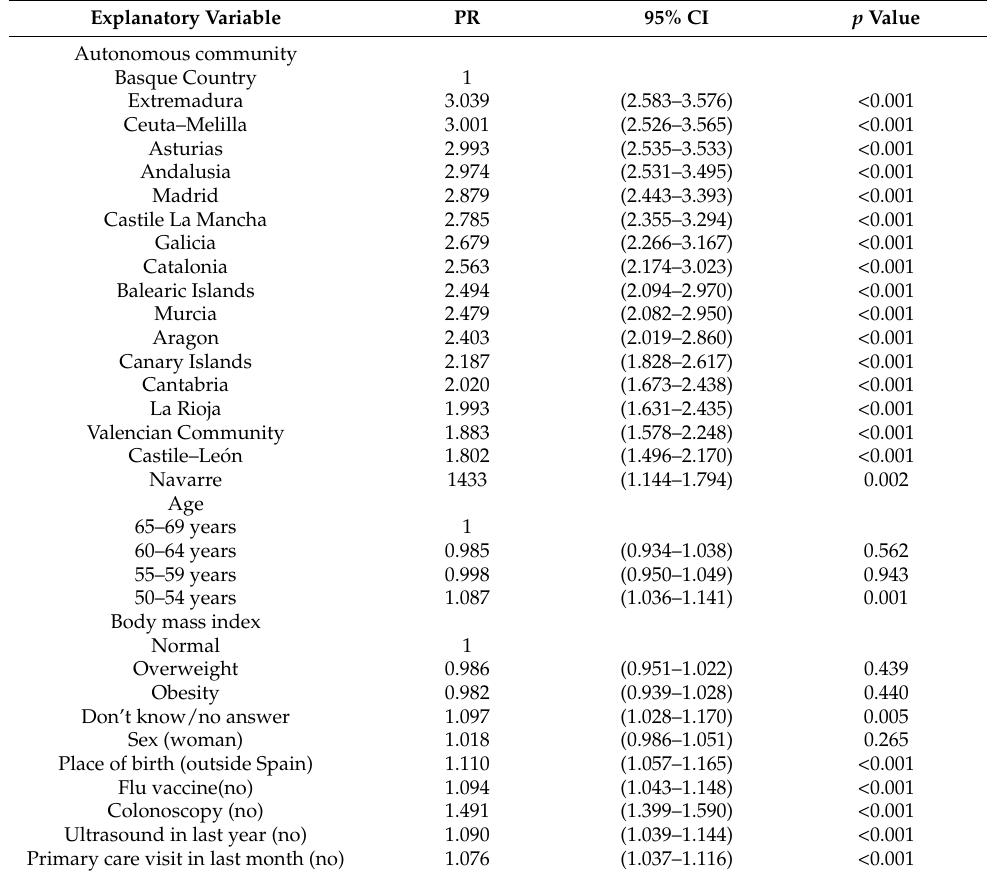
Table 2. Prevalence ratios (PRs) estimated by Poisson multiple regression with robust variance for not having had the faecal occult blood